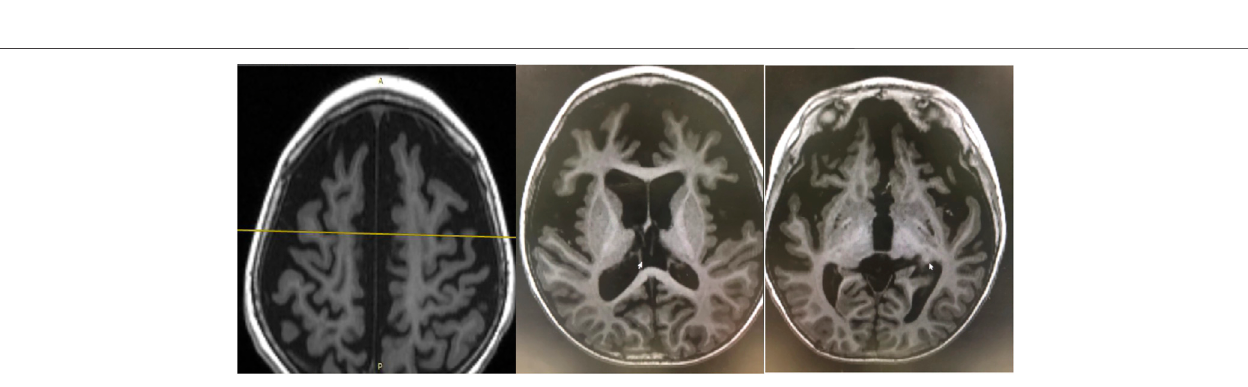
FIGURE 3 | Brain MRI of patient 4. Bilateral brain atrophy due to frequent seizures and status epilepticus without pyridoxine therapy at the age of three.